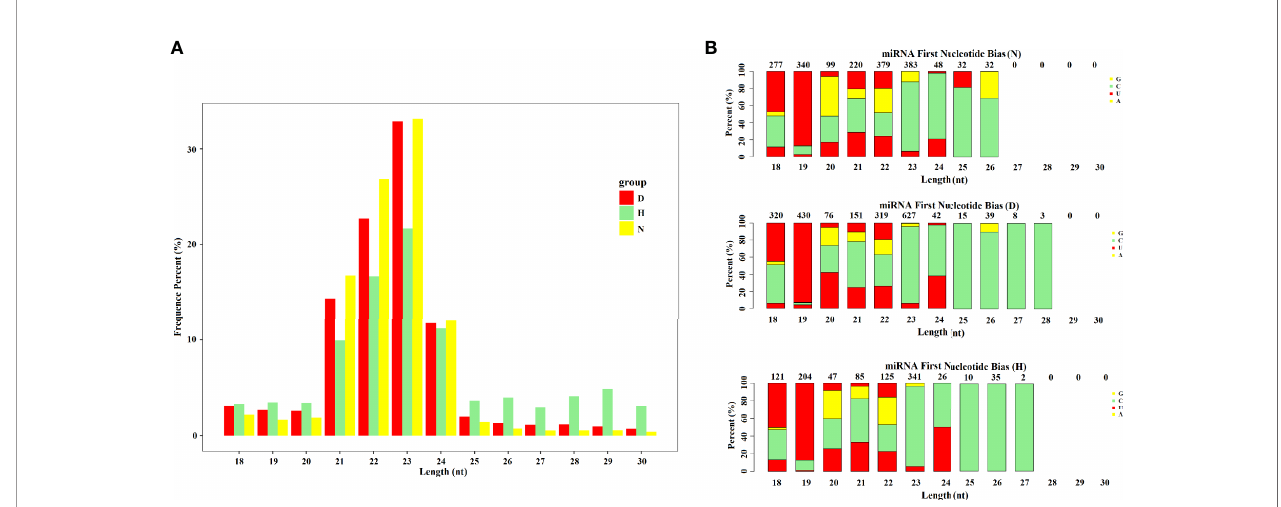
FIGURE 2 | Analysis of miRNA data of each group. (A) Length distributions of obtained miRNA in each group. (B) Analysis of the fi rst nucleotide bias of obtained miRNAs in each